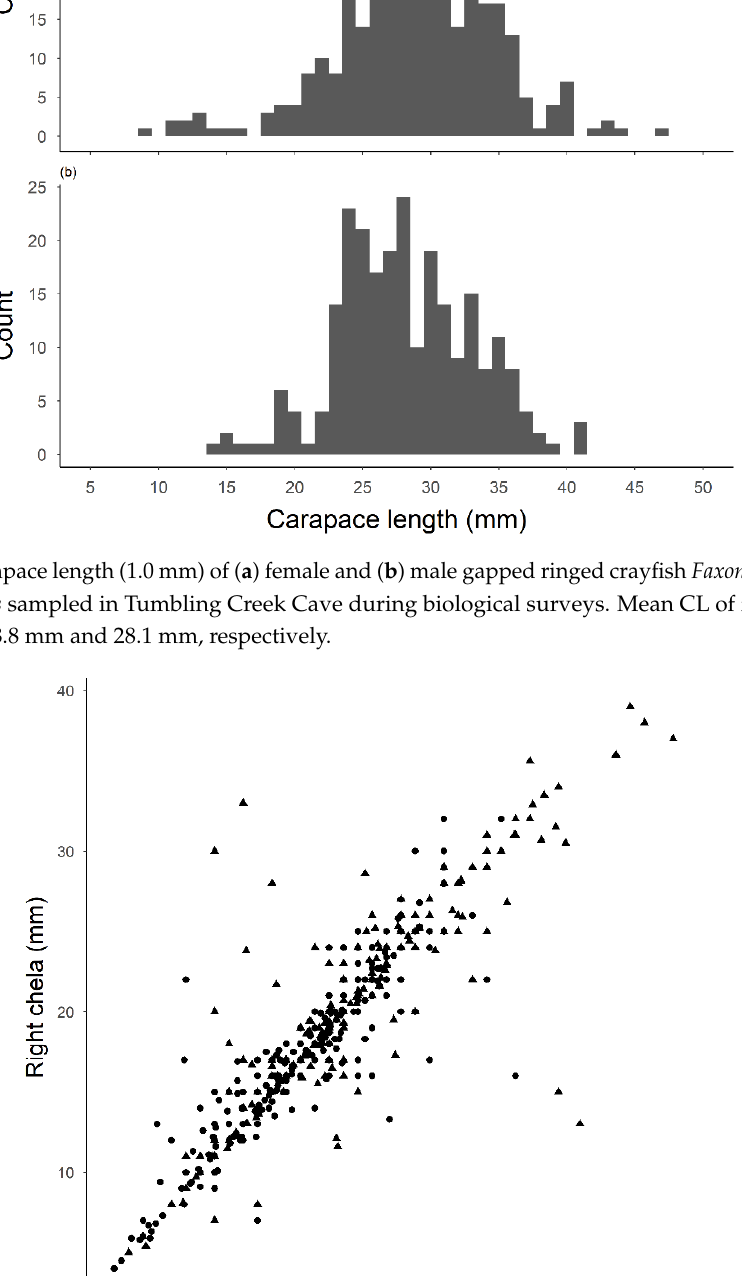
Figure 5. Comparison of the right and left chela length for both males (triangles) and females (circles). Males had significantly larger chelae (20.7 vs. 17.7 mm) and a greater difference between right and left chela (Y = 0.89X + 2.23; R 2 = 0.69) than did female crayfish (Y = 0.92X + 1.18; R 2 = 0.81).